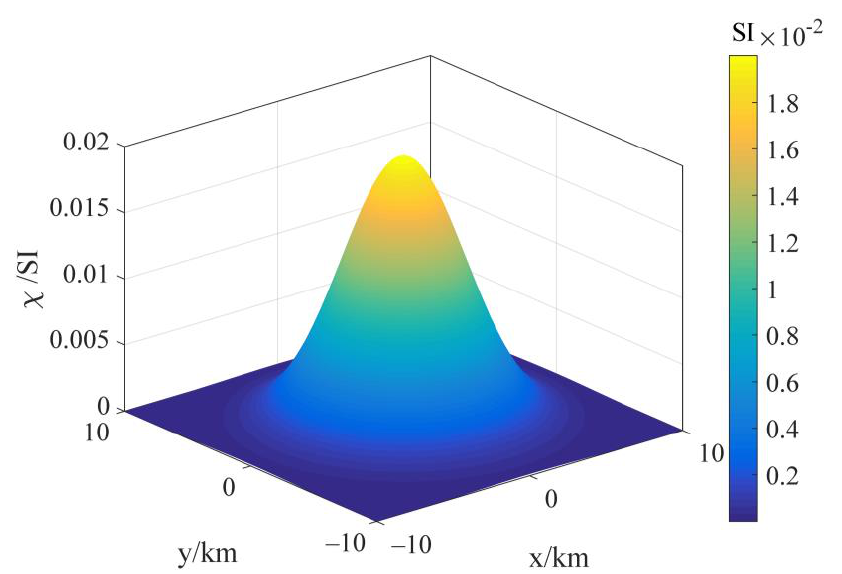
Figure 6. Magnetic susceptibility varying with horizontal coordinates. It represents the magnetic susceptibility change in each layer of the continuous model, and the magnetic susceptibility of different layers is the same.